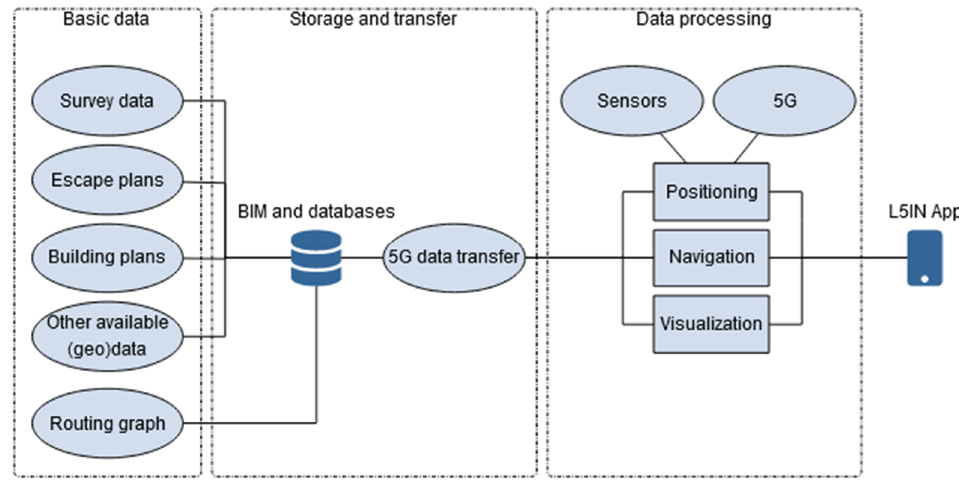
Figure 1. Components and structure of the indoor navigation application.